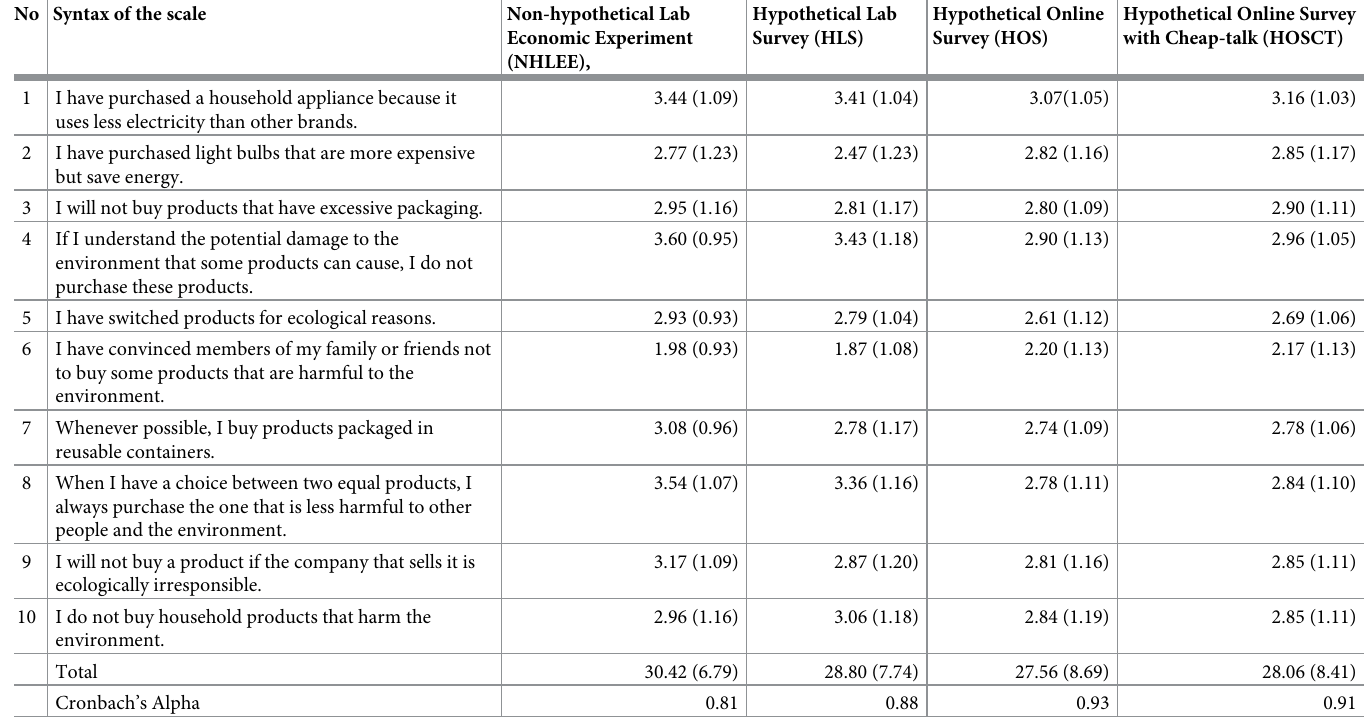
Table 4. Average ECCB